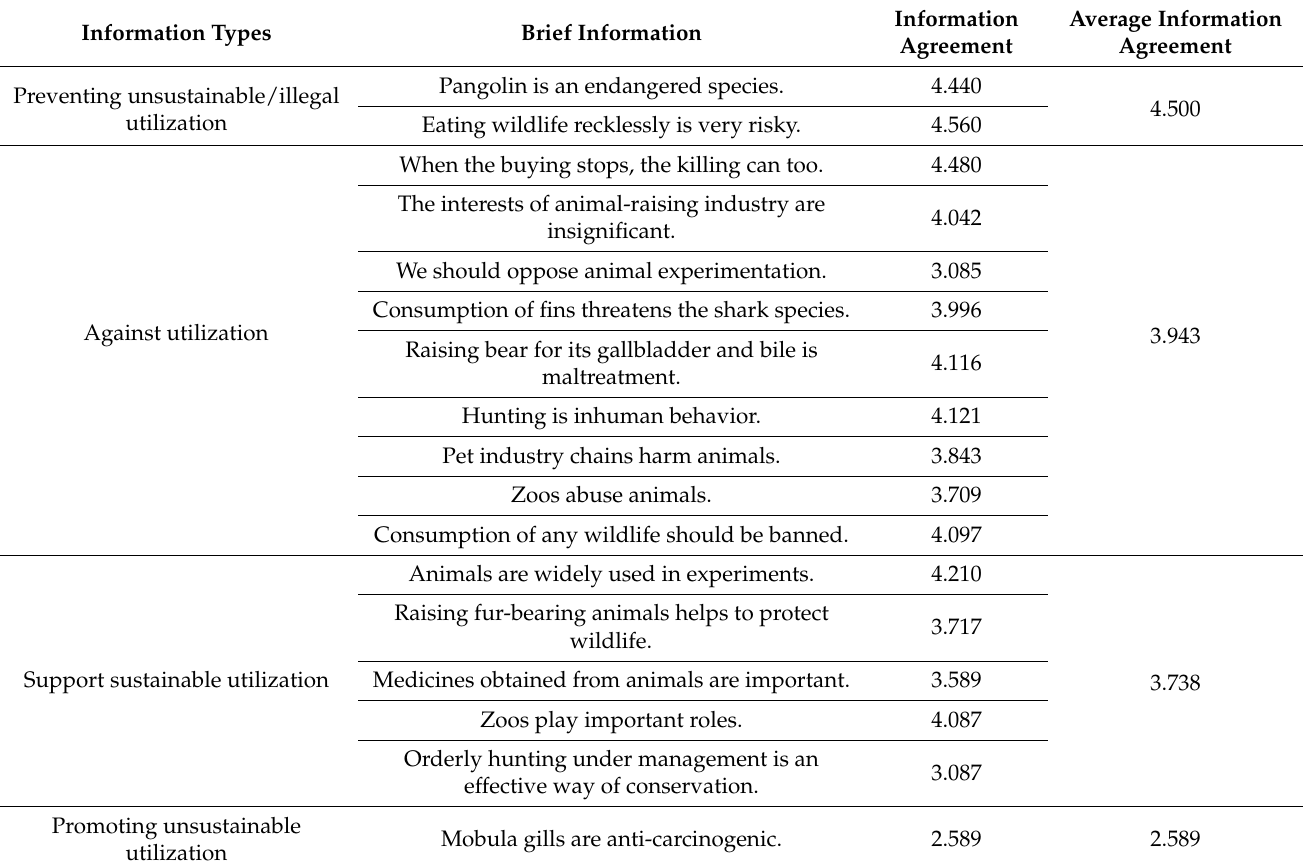
Table 2. Average Value of Agreement with